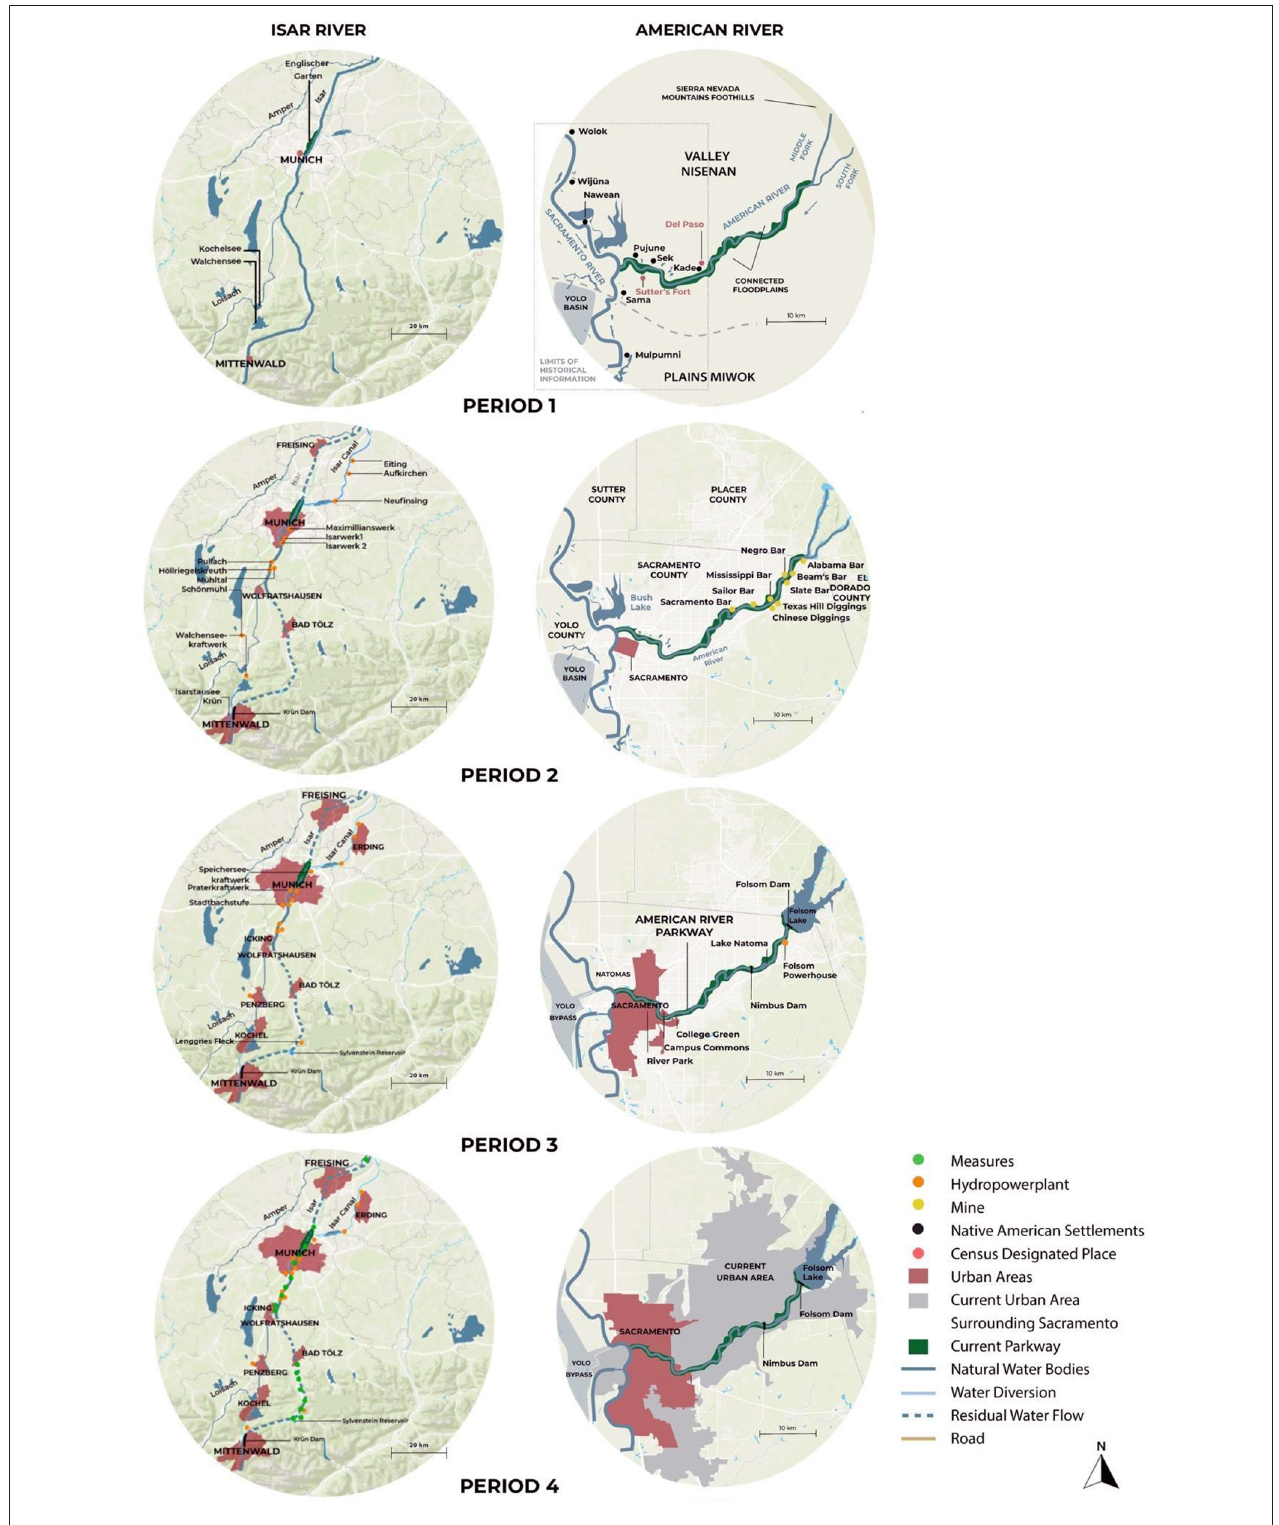
FIGURE 6 | Spatial evolution of the surroundings of the river corridors.